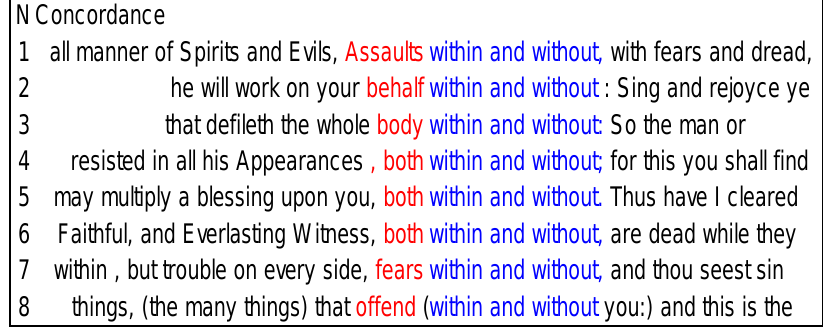
Figure 6. Illustrative concordance lines for both node spelling variants denied and denyed.